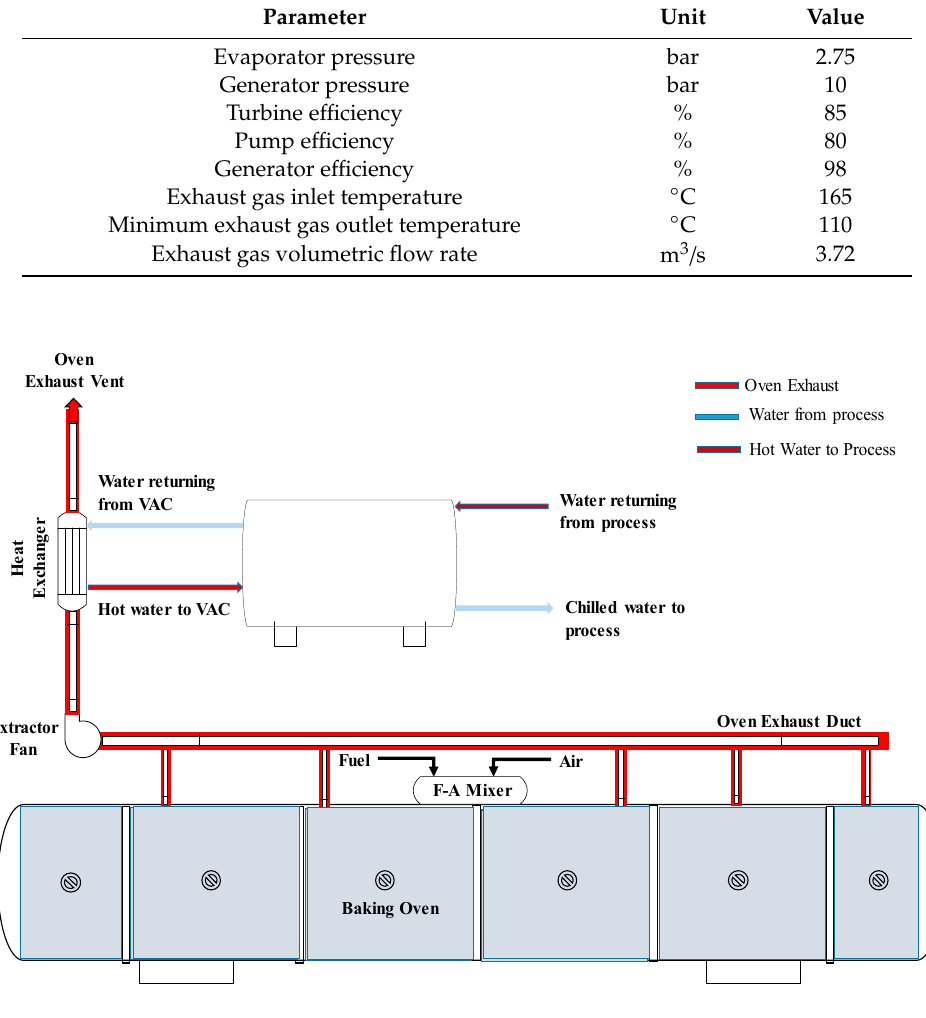
Figure 6. Schematic of a baking oven waste heat recovery system top produce chilled water using a vapour absorption